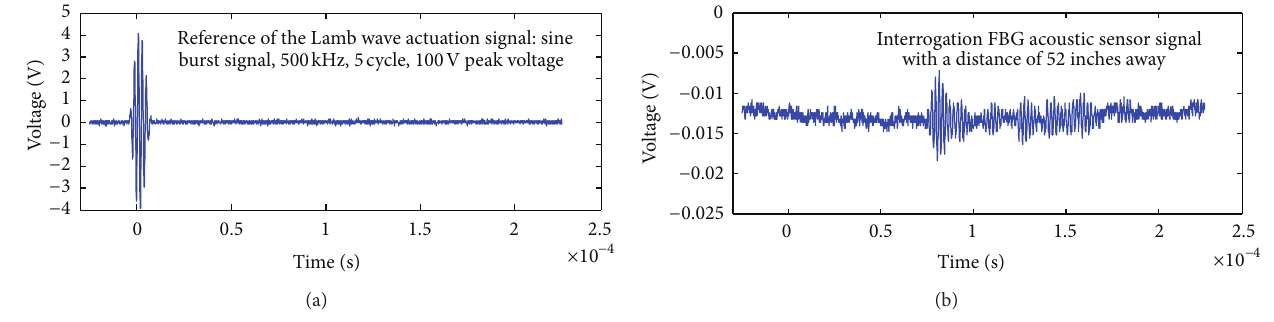
Figure 26: FBG response to acoustic wave excitation by a PZT